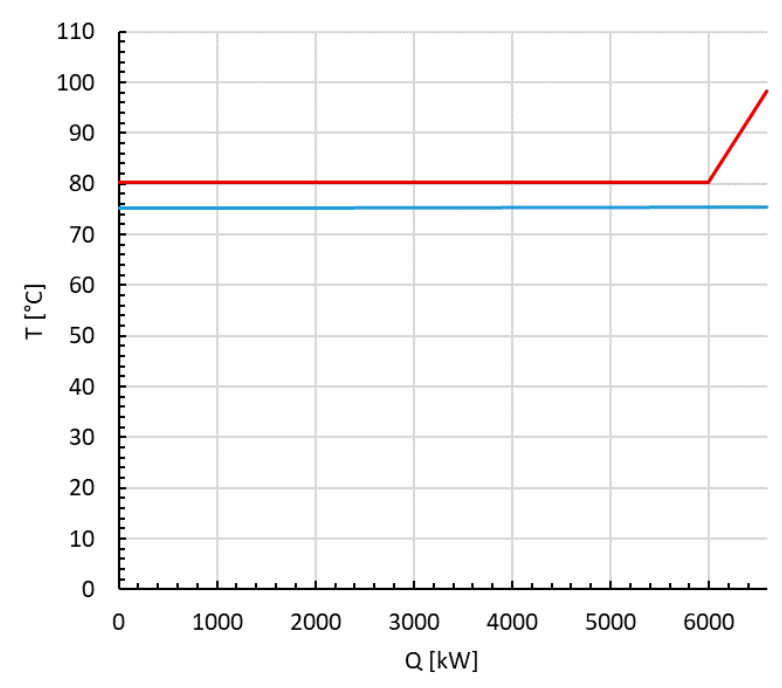
Figure 11. Temperature–enthalpy diagram of the MVC evaporator. Table 6. Results from basic design, CAPEX and OPEX estimation for the MVC desalination of waste geothermal brine.